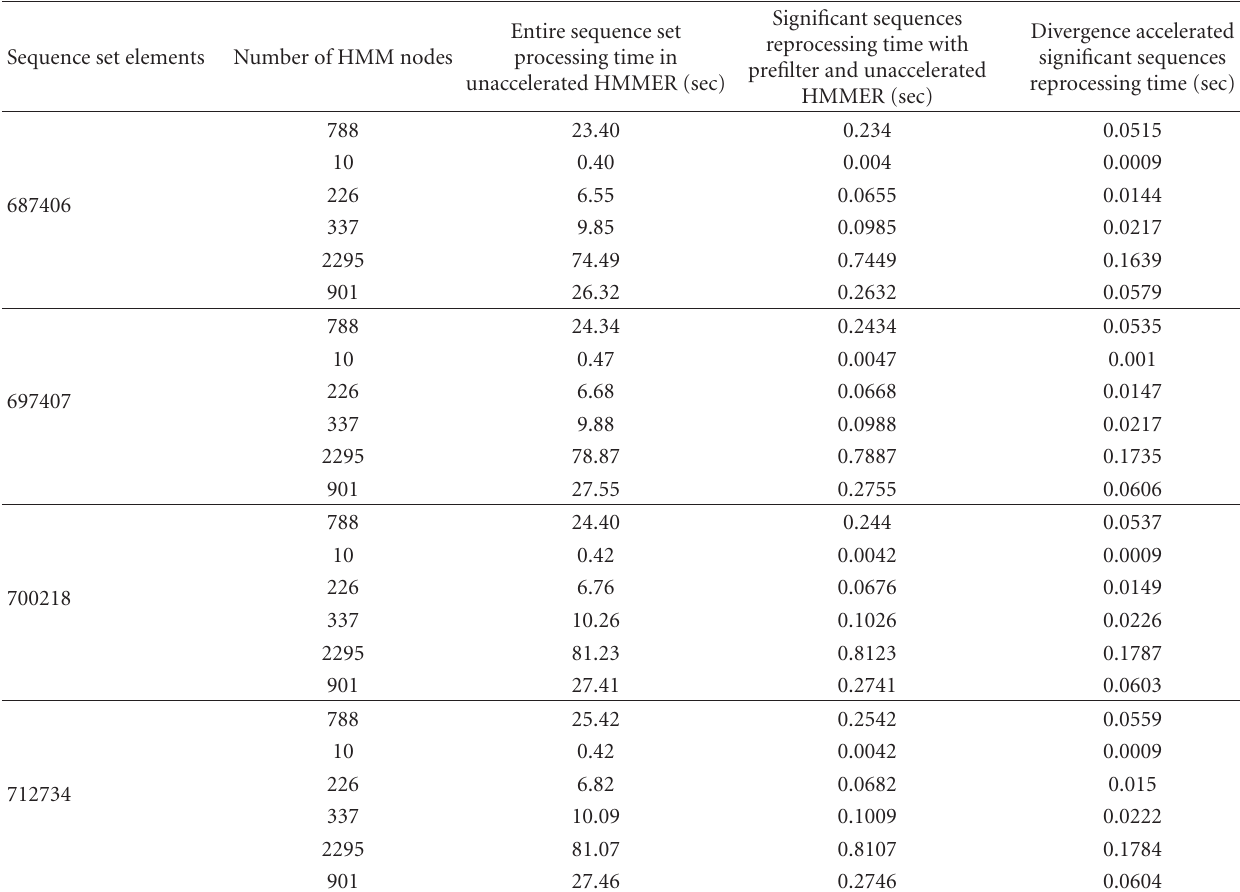
Table 6: Second-stage performance